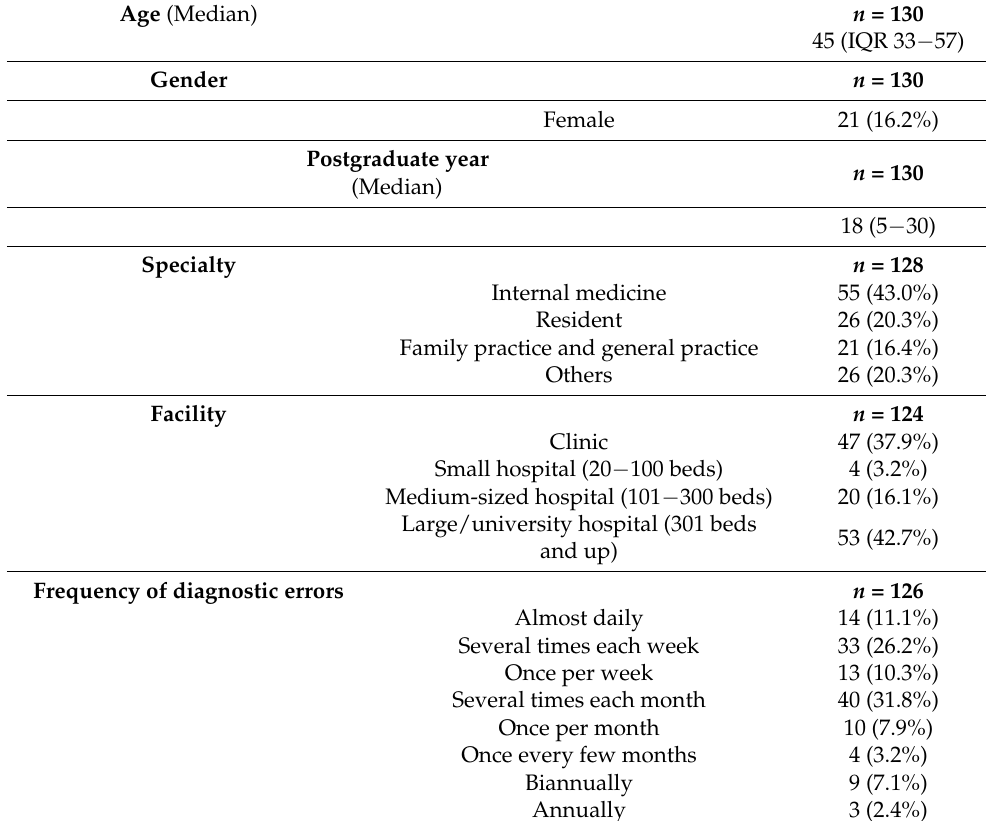
Table 2. Baseline characteristics of survey